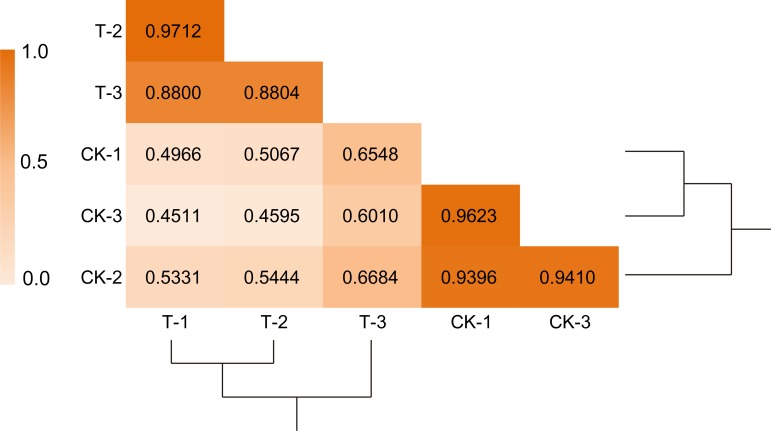
The pearson correlation coefficient between different biological replicates.The color scale shows the strength of the correlation, and the deeper color indicates higher correlation.